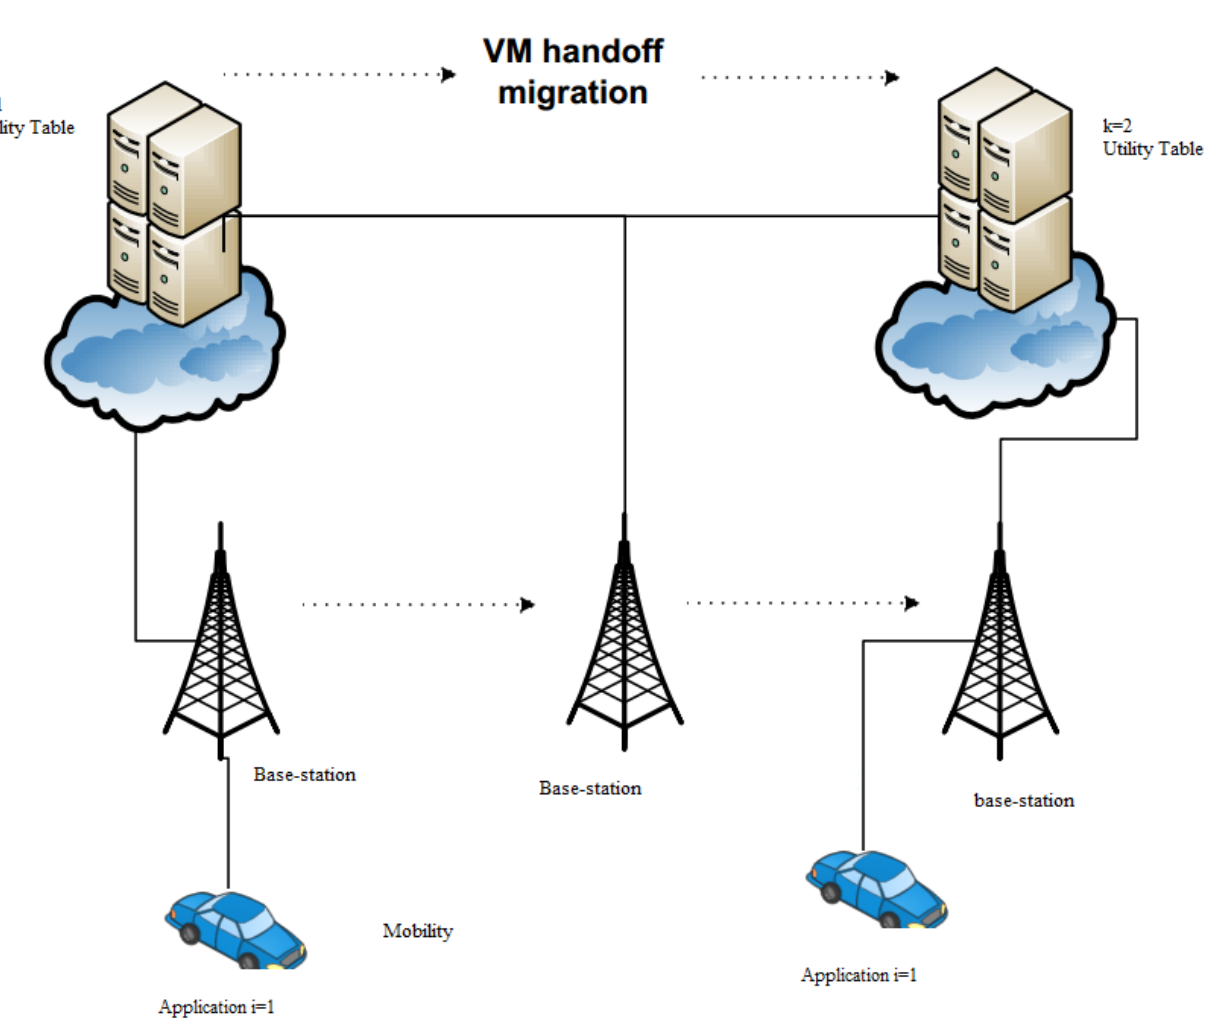
Figure 4. E-Transport Mobility in the